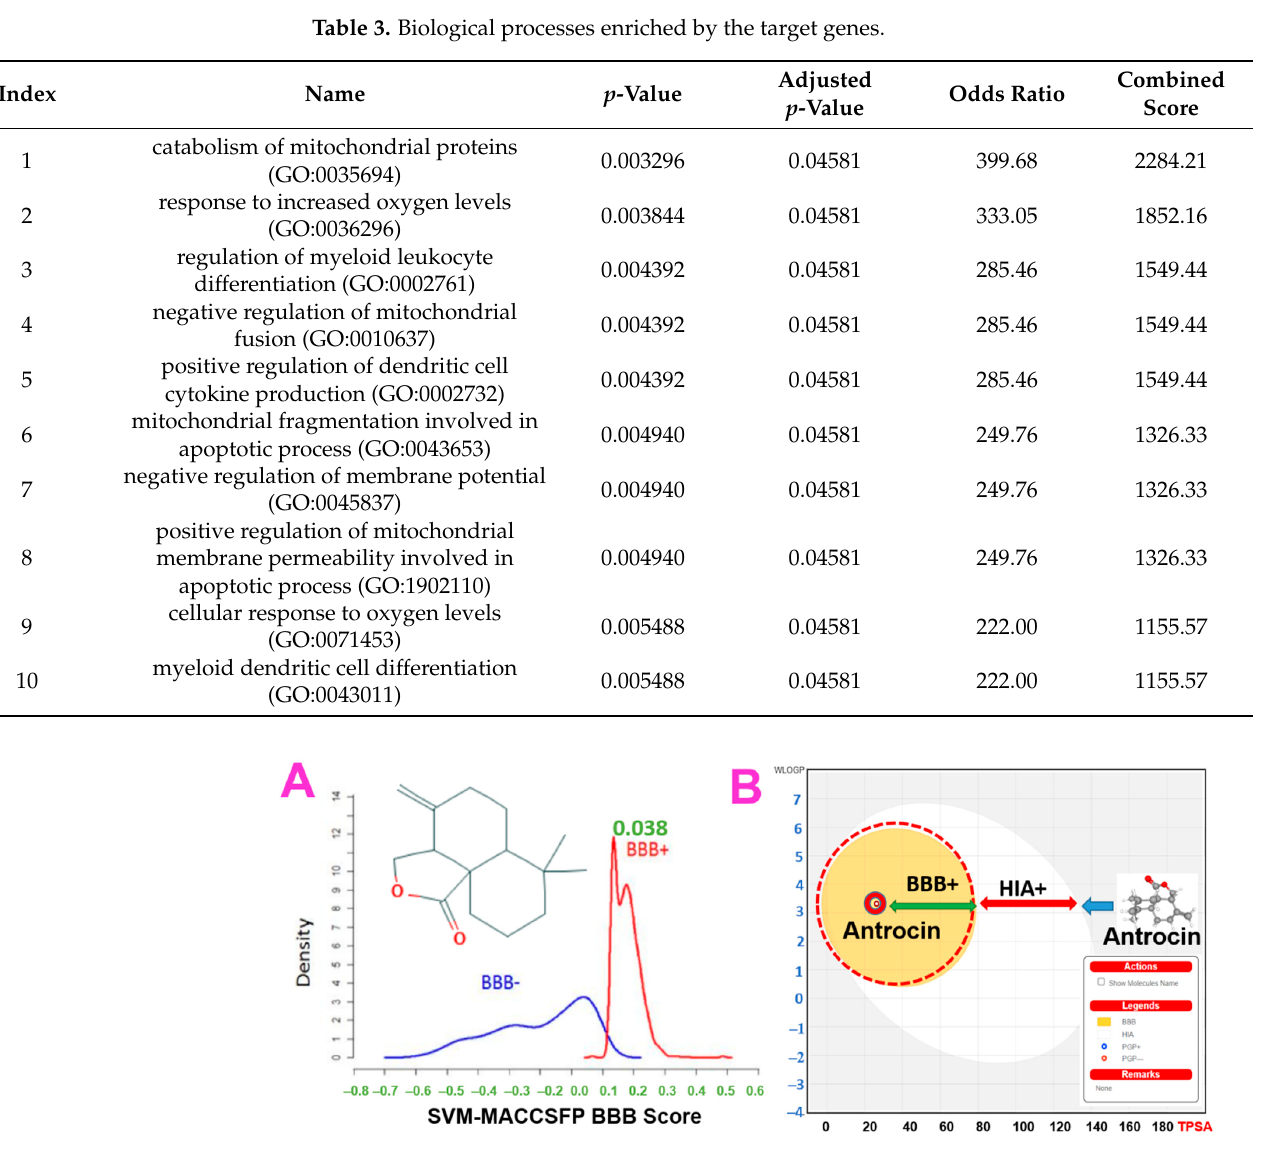
Figure 7. Two-dimensional (2D) structure and blood–brain barrier (BBB) permeation ability of antrocin. The ( A ) support vector machine (SVM)/LiCABEDS algorithms and ( B ) BOILED-Egg) model of BBB permeability of antrocin. Table 4. In silico acute rodent toxicity assays for antrocin.